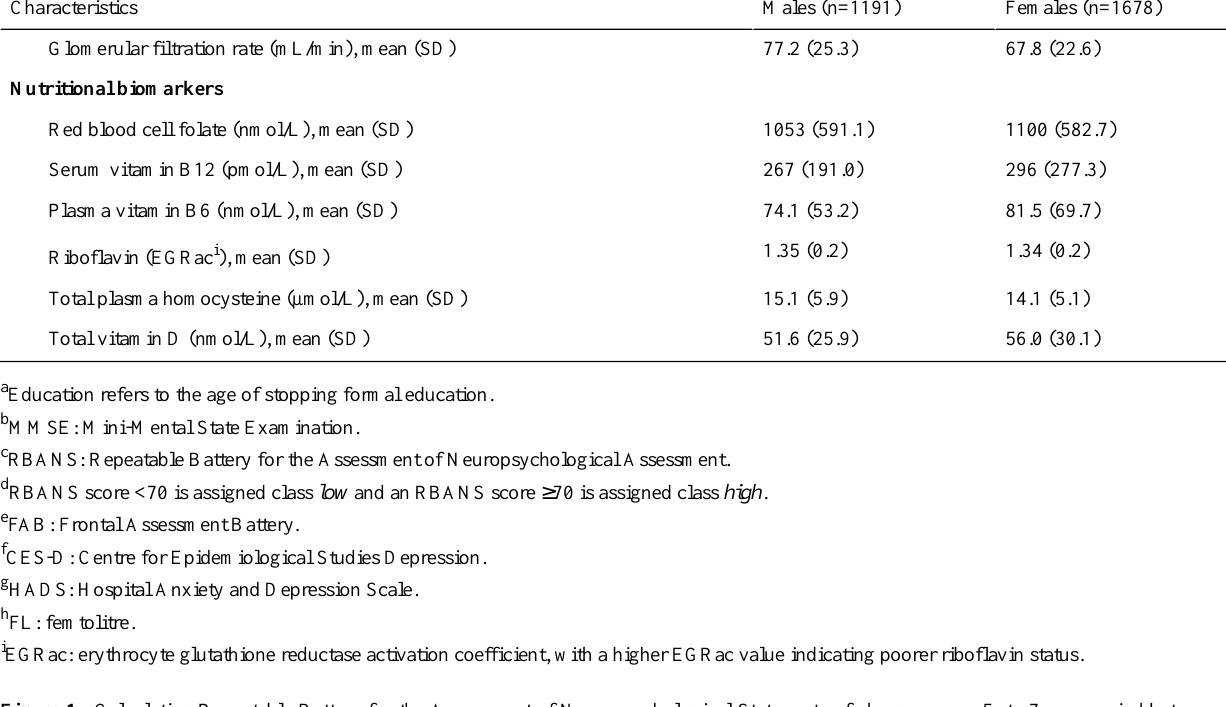
Figure 1. Calculating Repeatable Battery for the Assessment of Neuropsychological Status rate of change over a 5- to 7-year period between initial assessment and follow-up assessment, normalized to account for the time between each assessment.